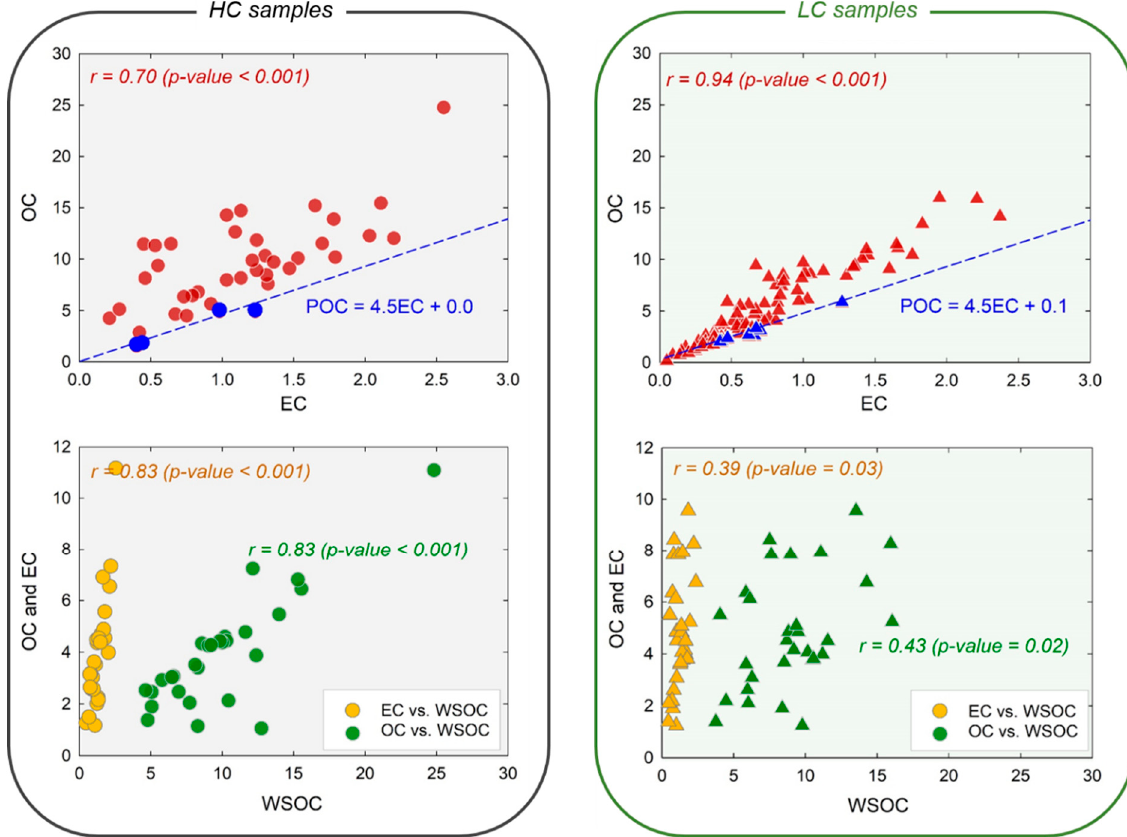
Figure 6. Correlations between carbonaceous compounds in the HC ( left panels) and LC ( right panels ) samples.